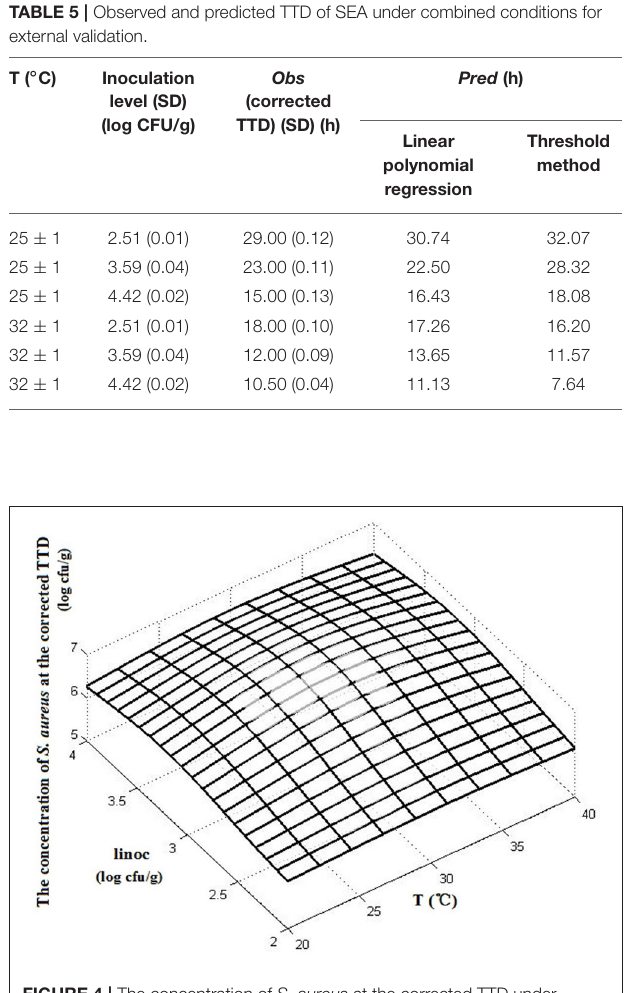
FIGURE 4 | The concentration of S. aureus at the corrected TTD under various